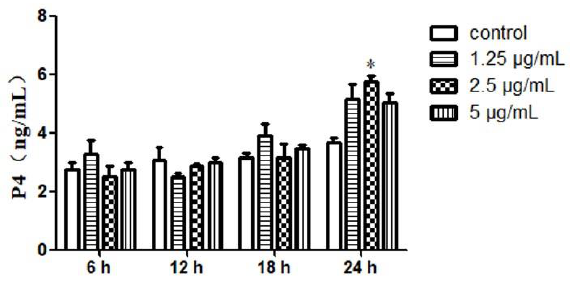
Figure 4. The level of P4 secretion in cultured granulosa cells treated with Ost at various time points. ELISA was used to determine the content of P4. Data were expressed as Mean ± SEM. * p < 0.05.